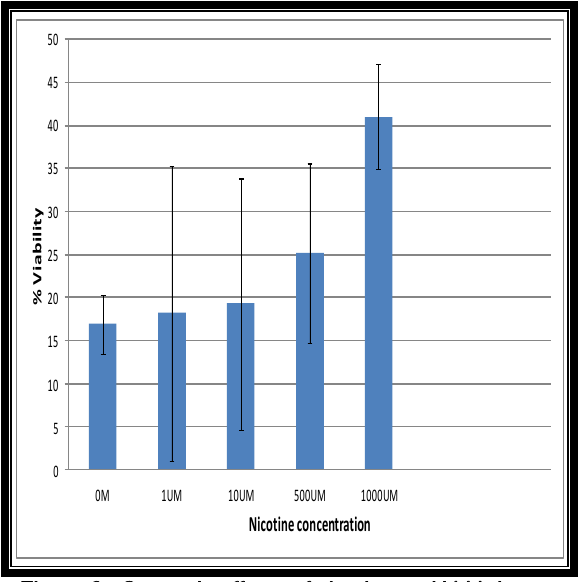
Figure 2 : Cytotoxic effects of nicotine on H441 lung cancer cells by MTT assay with wave length of 570